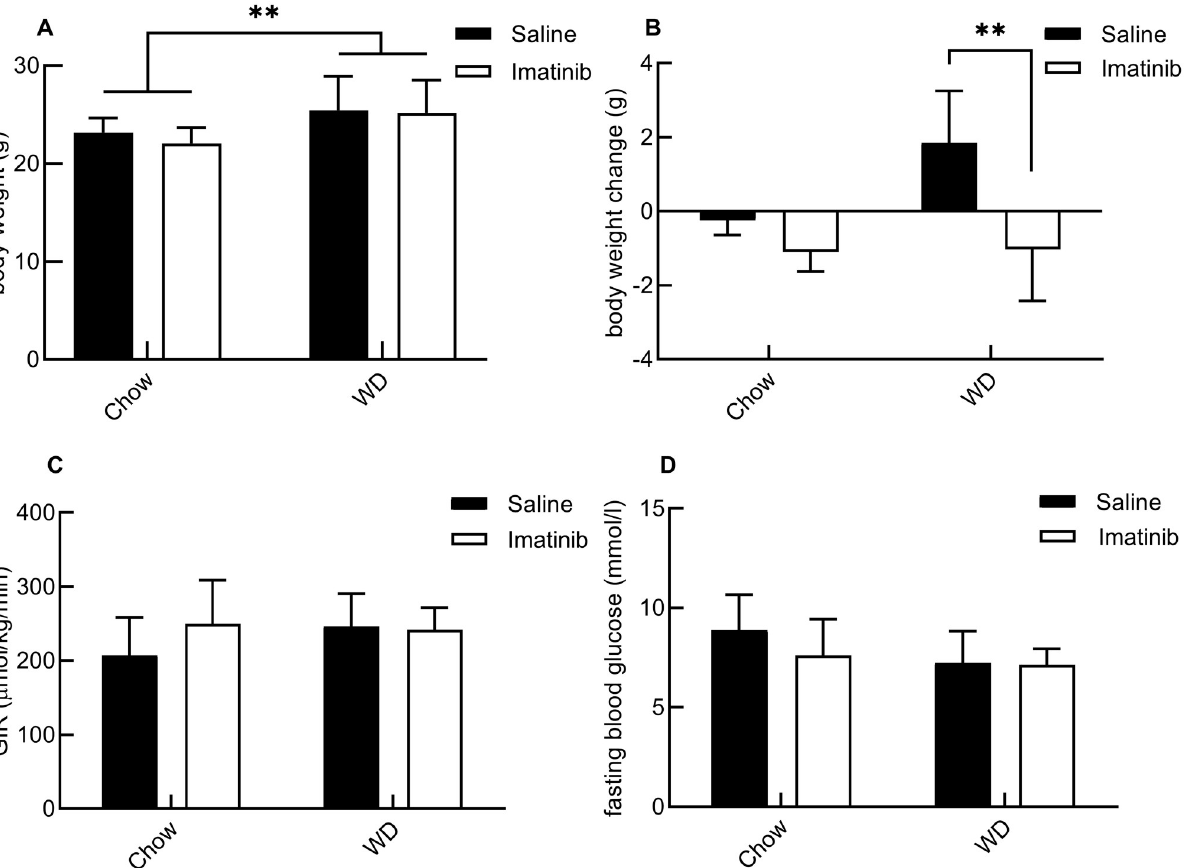
Fig 1. The effect of imatinib and Western Diet (WD) on body weight, metabolic insulin sensitivity and glucose metabolism. A: WD-fed mice had higher body weight than chow fed mice after two weeks of diet (P = 0.007, n = 8). B: Two-week WD feeding caused bodyweight gain in mice given saline injections. This weight-gaining effect was rescued by imatinib treatment ( P = 0.006, n = 8). C: Glucose infusion rate (GIR) quantifies whole-body glucose uptake during the hyperinsulinemic-euglycemic clamp. Two-week Western diet feeding and imatinib treatment did not affect GIR: P = 0.42 and P = 0.32, respectively (n = 5–7). D: Two-week Western diet feeding and imatinib treatment did not affect fasting glucose levels: P = 0.07 and P = 0.23, respectively (n = 7–8). Results were tested for significance with two-way ANOVA tests. �� P < 0.01.